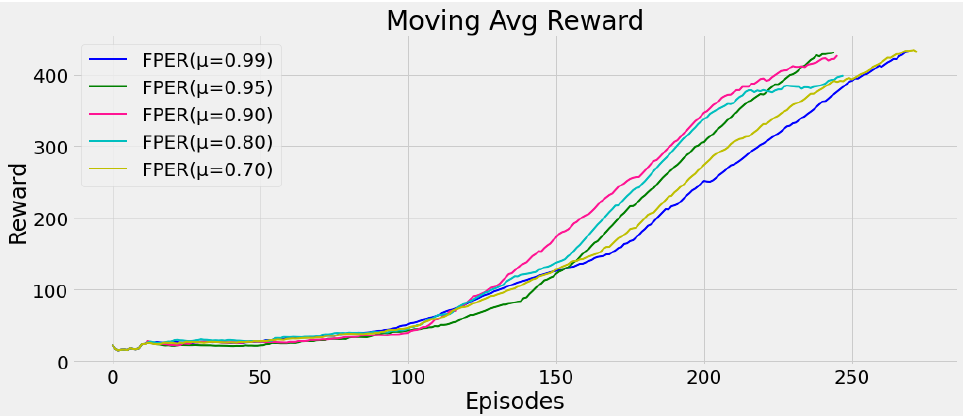
Figure 4. Effect of different values of µ on CartPole-v1.